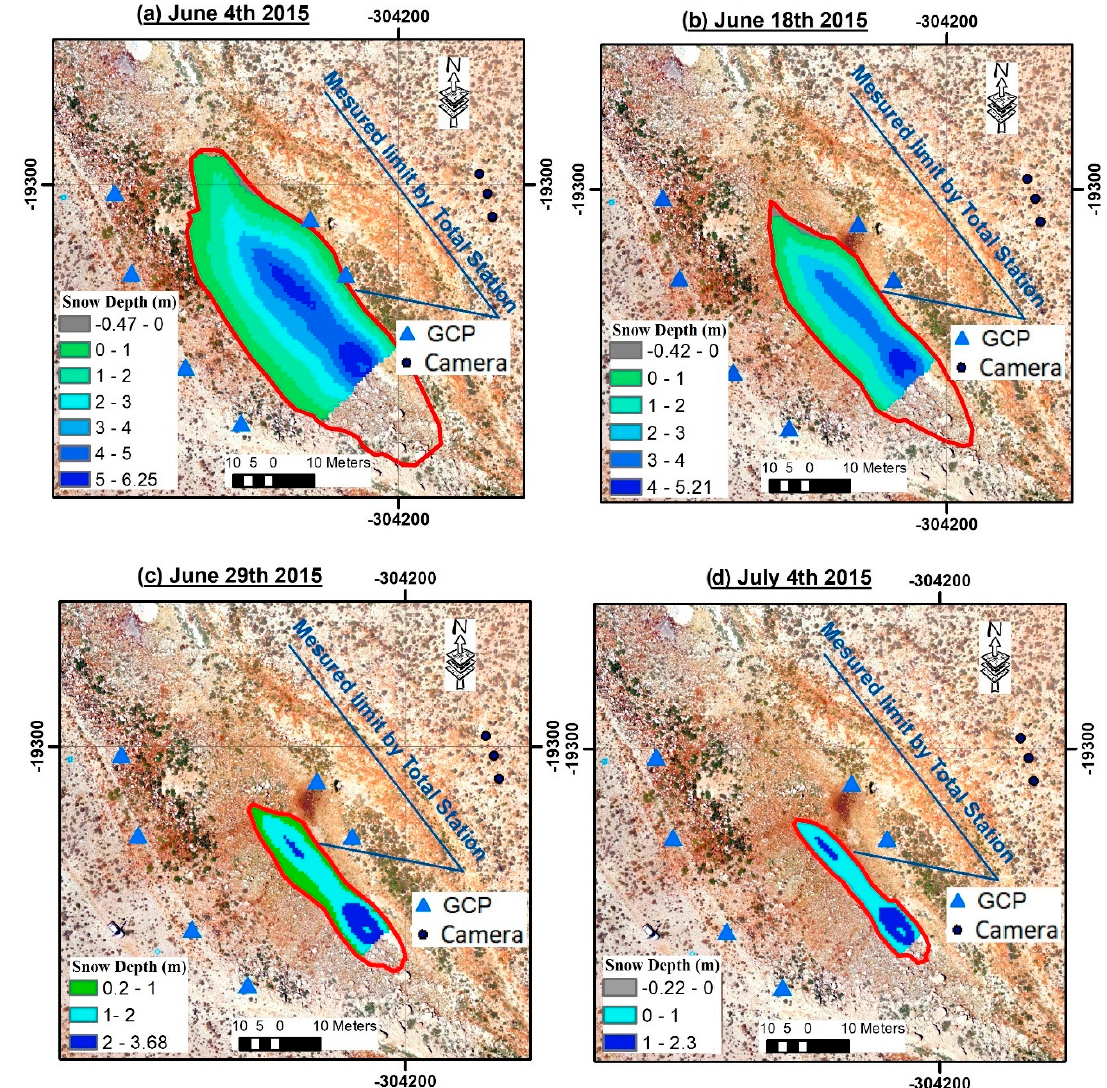
Figure A1. Snow depth maps of Exp.1.